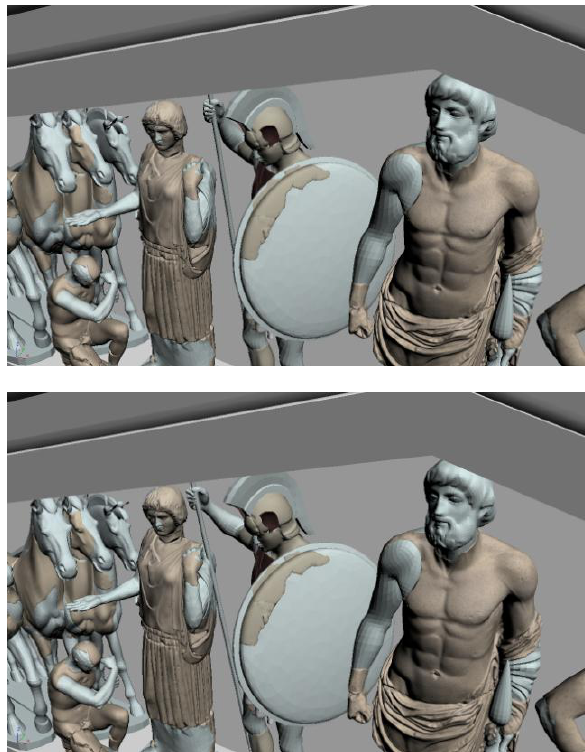
Figure 9. Different poses of figure G. The position of the right arm holding a spear was tested by animating the model.